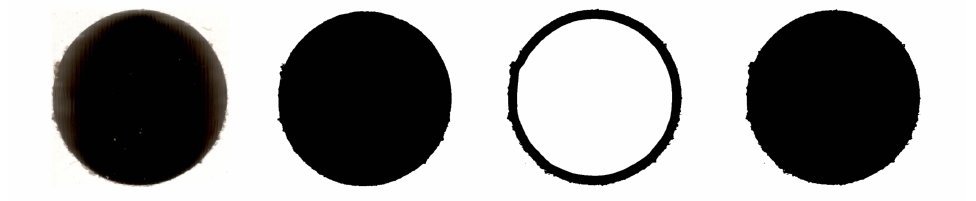
Figure 4. Steps of segmentation ( left to right ): input scan, “bw”, “bw2”, “bw” + “bw2”.